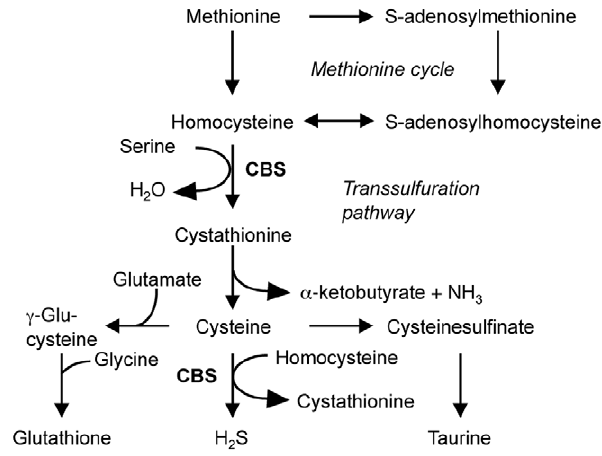
Figure 1. Involvement of CBS in sulfur-containing amino acid metabolism. From Stipanuk [54].